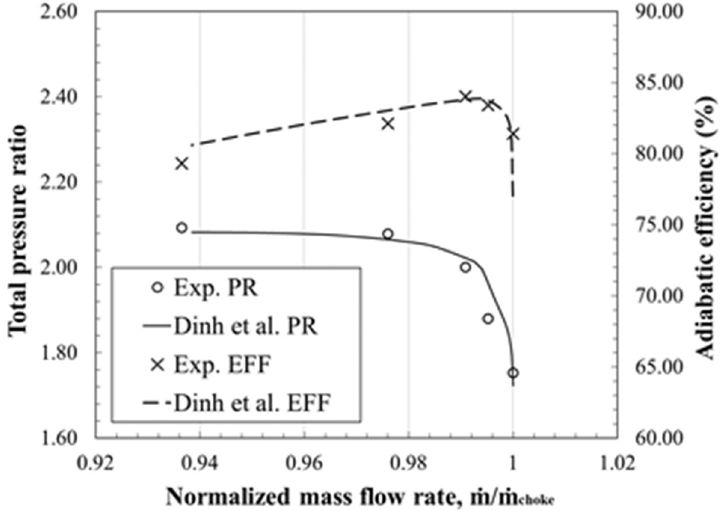
Figure 3. Validation of numerical results for NASA Stage 37 compressor model [10] against experi- mental measurement [27].